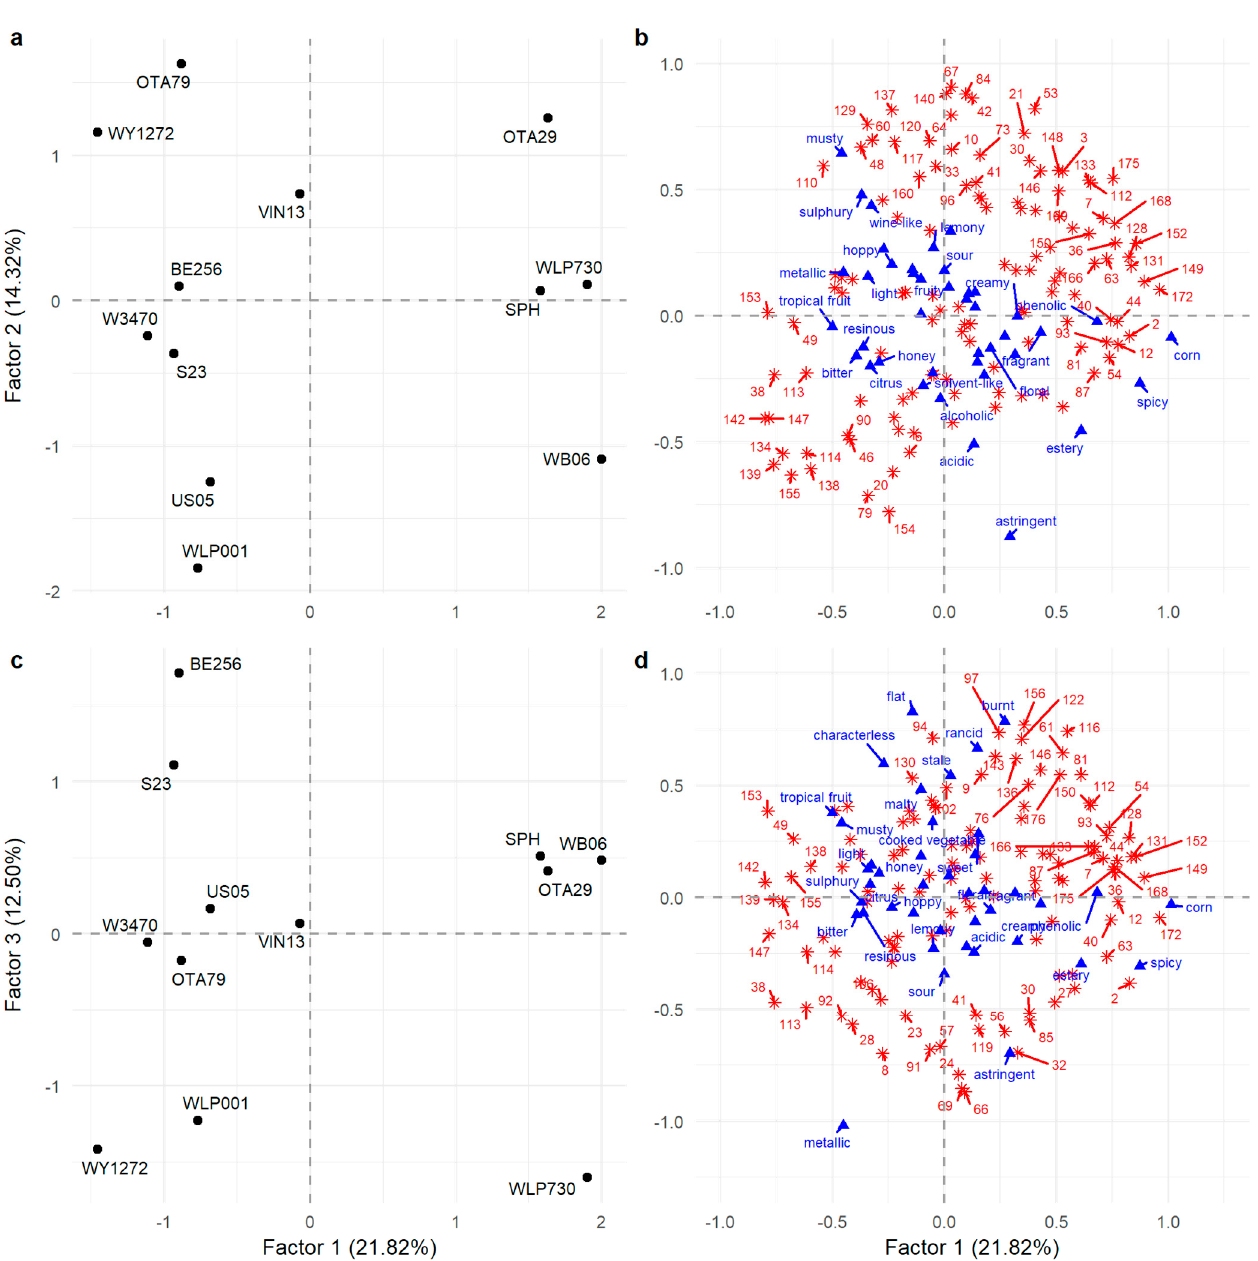
Figure 2. Separation of twelve beer samples ( a , c ) with sensory attributes (blue triangles) and VOCs (red asterisks) ( b , d ) on the MFACT plot on Factors 1–3. Labelled VOC numbers correspond to important contributors; refer to Appendix A, Table A2 for VOC identification.